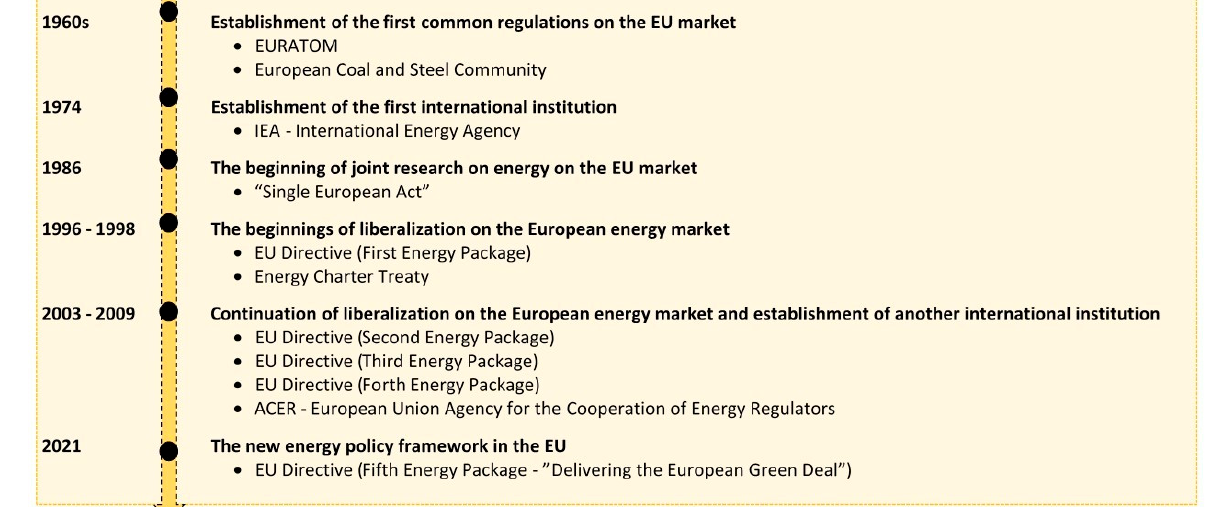
Figure 2. Changes related to the research, liberalization, consolidation and common energy